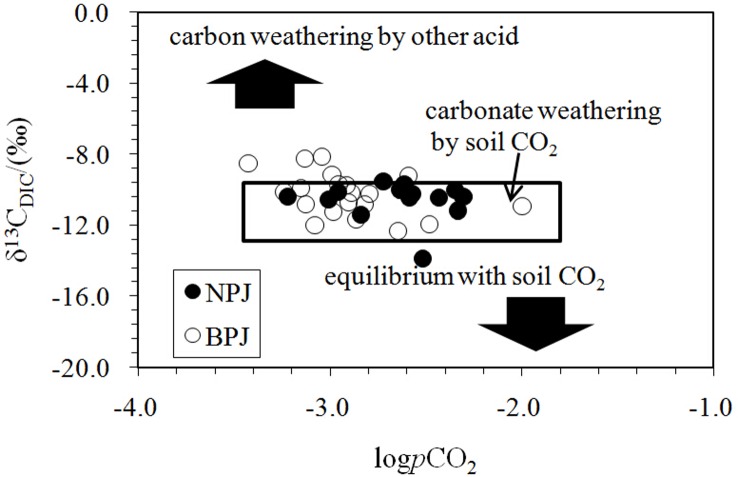
Plot showing changes in δ13CDIC as a function of logpCO2.The range of carbon isotopic and logpCO2 values shown by the box for carbonate weathering was obtained from a previous investigation within the Houzhai catchment, southwest China [22]. The Houzhai catchment has a similar type of plants and cultivation to the upper reaches of Xi River.